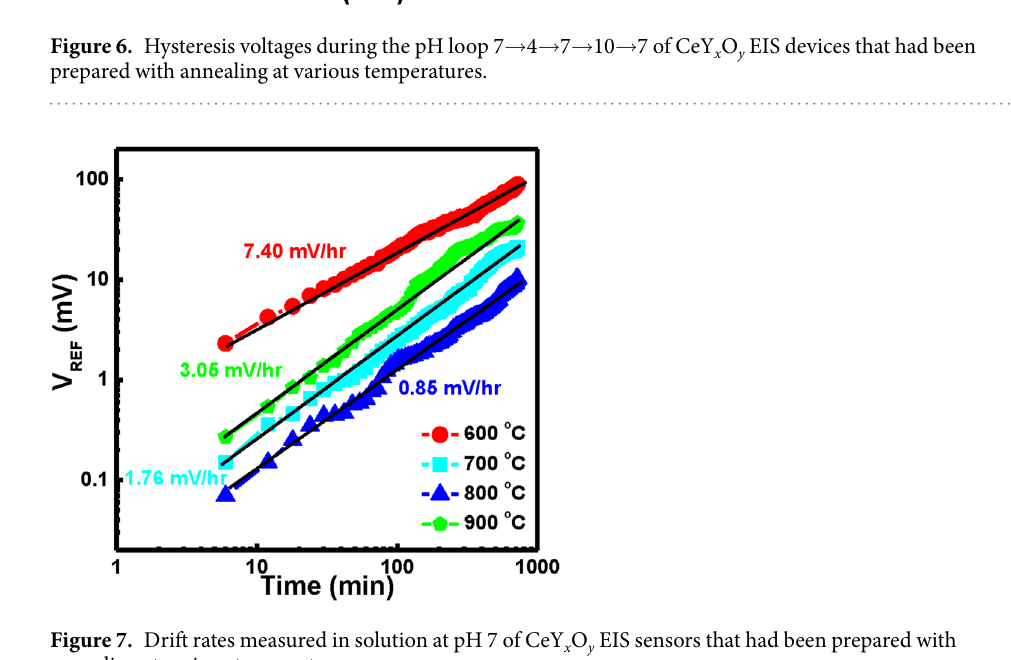
Figure 7. Drift rates measured in solution at pH 7 of CeY x O y EIS sensors that had been prepared with annealing at various